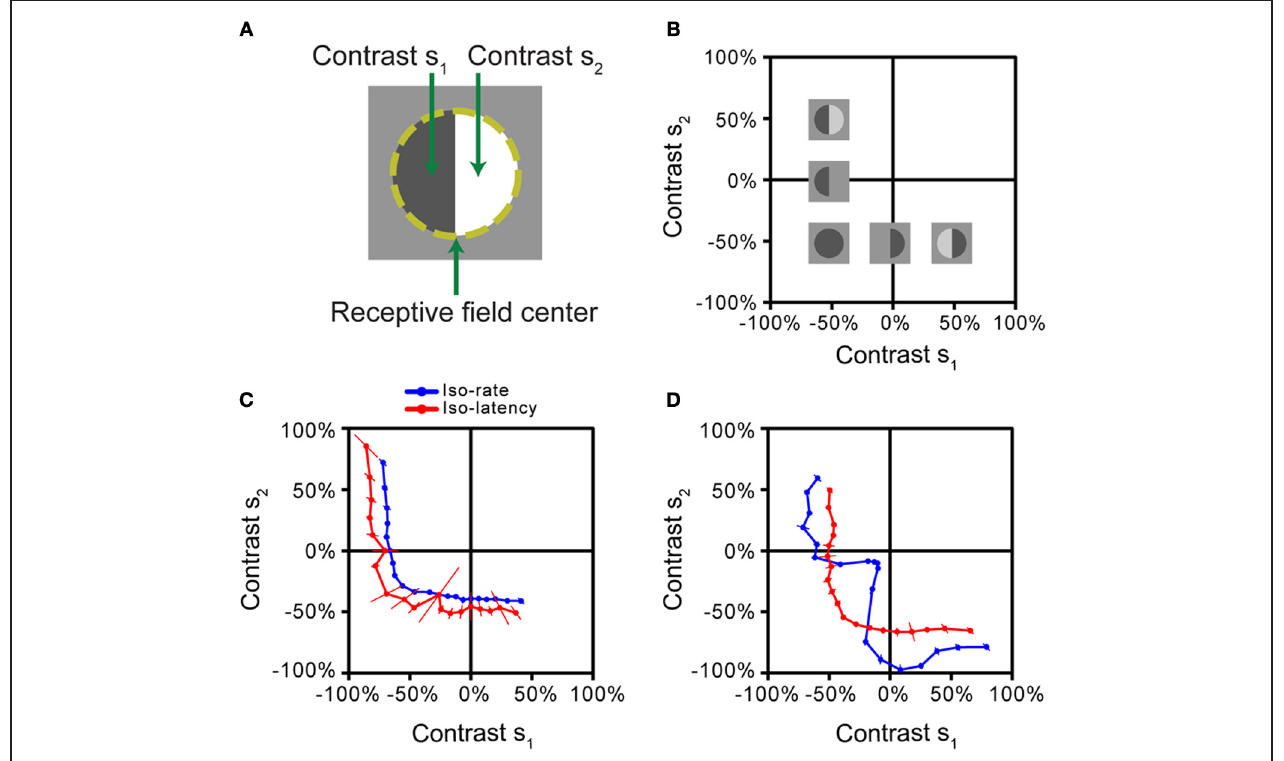
FIGURE 4 | Iso-response measurements of spatial stimulus integration by retinal ganglion cells. (A) Stimulus pattern used in the measurements. After determining the receptive field center of a retinal ganglion cell (dashed line), different contrast levels s 1 and s 2 were simultaneously displayed for 500ms, each in one half of the receptive field. (B) Stimulus space. Iso-response stimuli were measured in the space spanned by s 1 and s 2 . Experiments were performed on Off-type ganglion cells, which best respond to negative contrast. Several sample stimulus patterns are shown at their respective locations in stimulus space. The origin corresponds to the gray level of background illumination. (C) Iso-rate and iso-latency curves for a